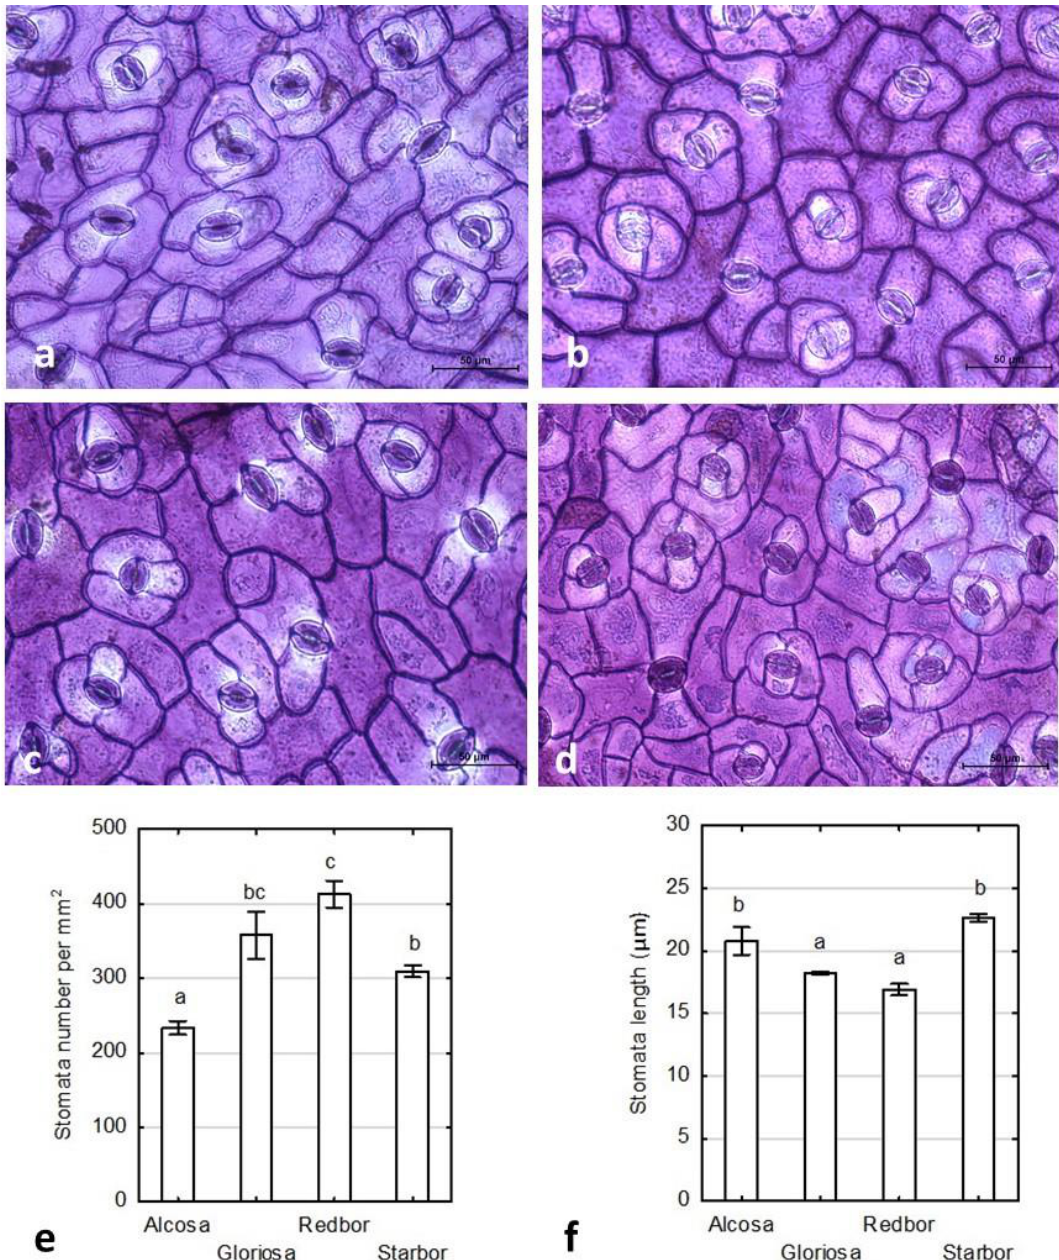
Figure 4. Abaxial epidermis of savoy cabbage and kale cultivars. ( a – d ) Optical micrographs stained with toluidine blue (LM). ( a ) “Alcosa”, ( b ) “Gloriosa”, ( c ) “Redbor”, ( d ) “Starbor”, ( e , f ) Morphological characteristics (mean ± 1SE) (one-way ANOVA followed by Newman-Keuls test: p < 0.05). Means with the same letter are not significantly different. ( e ) Number of stomata per 1 mm 2 , ( f ) Length of stomata in µm.